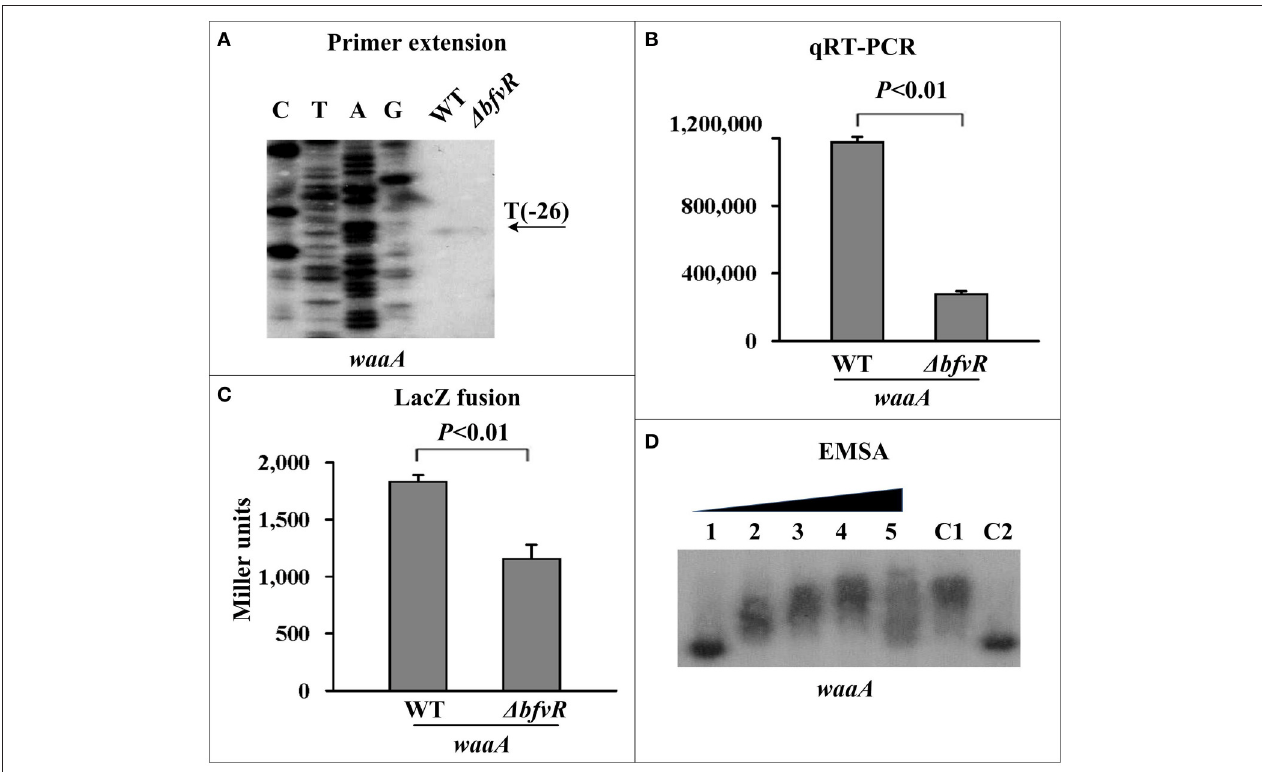
FIGURE 3 | Regulation of waaAE-coaD by BfvR. Reference to Figure 2 for the explanation of primer extension (A) , quantitative RT-PCR (B) , LacZ fusion (C) , and EMSA (D) . The promoter-proximal region from − 574 to + 62 was